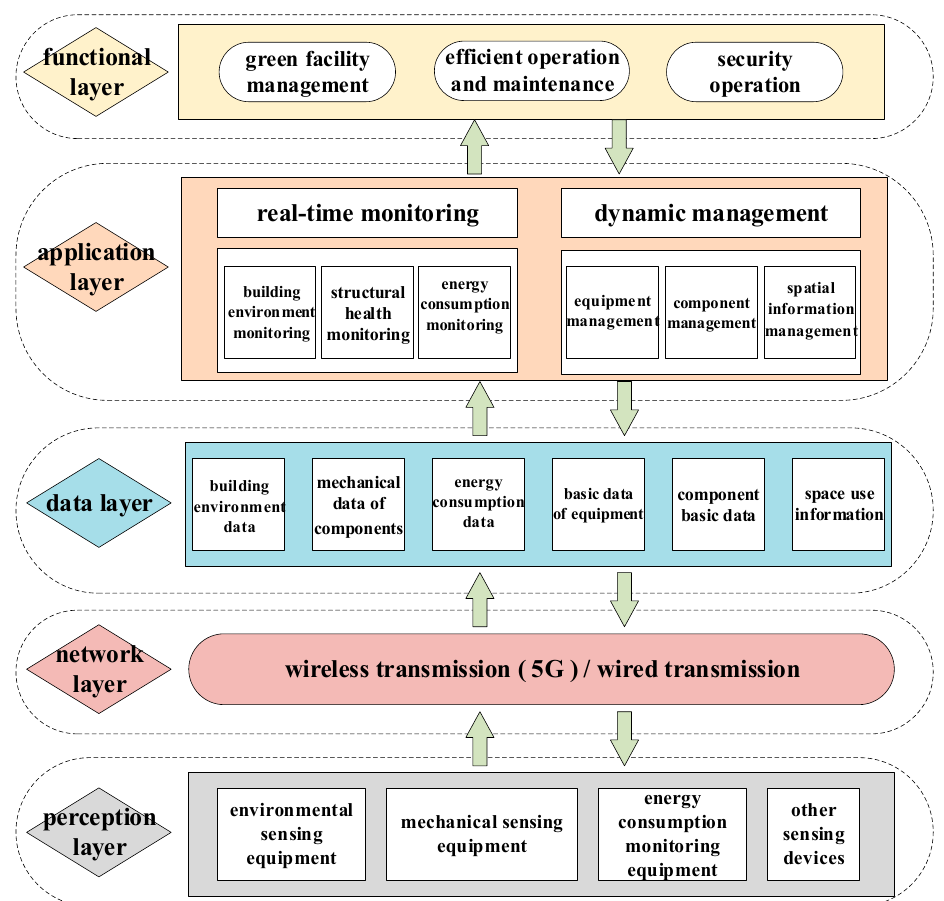
Figure 11. Technical architecture of O&M